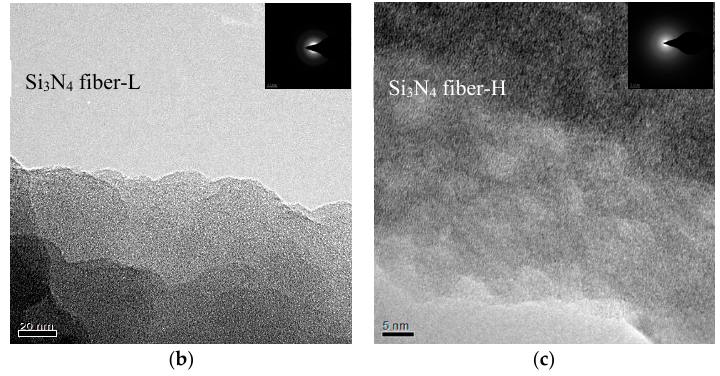
Figure 3. ( a ) X-ray diffraction (XRD) patterns of Si 3 N 4 fibers prior to and following heat treatment and ( b , c ) transmission electron microscopy (TEM) patterns of untreated fibers.